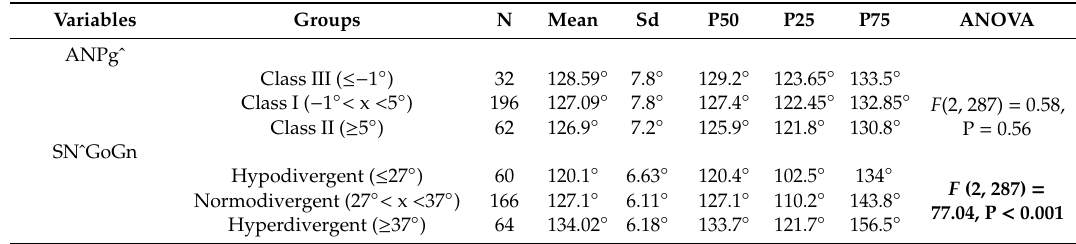
Table 2. Distribution of the CoGoMeˆ according to the ANPgˆ and the SNˆGoGn. Di ff erences in CoGoMeˆ among individuals with di ff erent ANPgˆ and SNˆGoGn were estimated as appropriate using one-way ANOVA. Bold text indicates statistically significant di ff